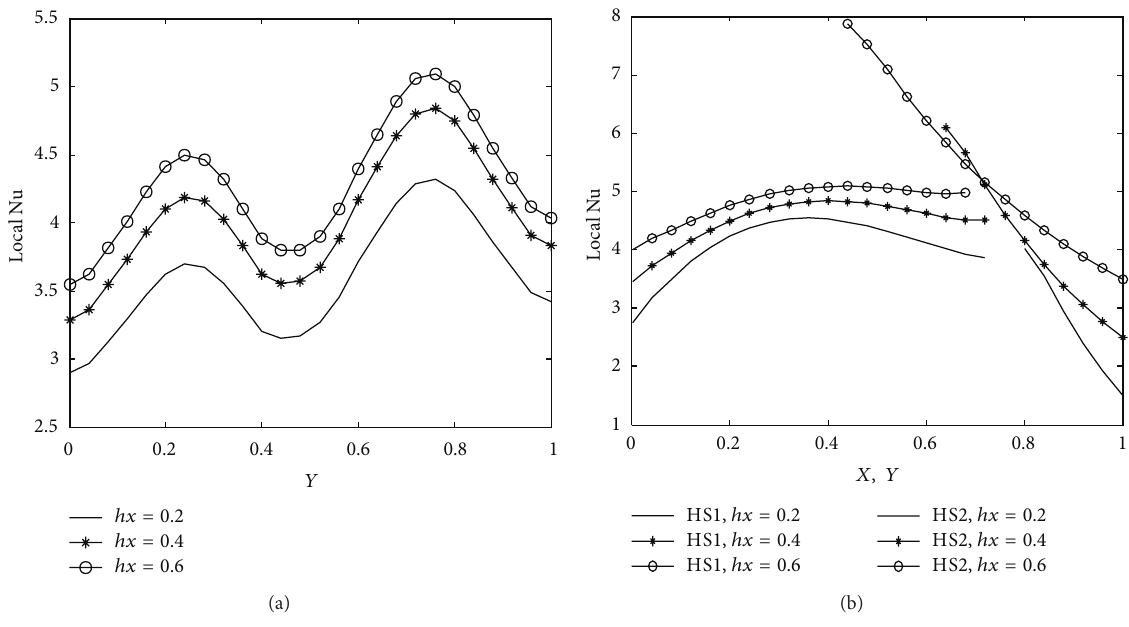
Figure 13: Variation of local nusselt number with heater length in horizontal direction at Ra = 10 5 , Pr = 0.7 , 𝐴 = 0.2 , 𝑛 = 2 , and ℎ𝑦 = 0.8 (a) along cold wavy surface and (b) along the